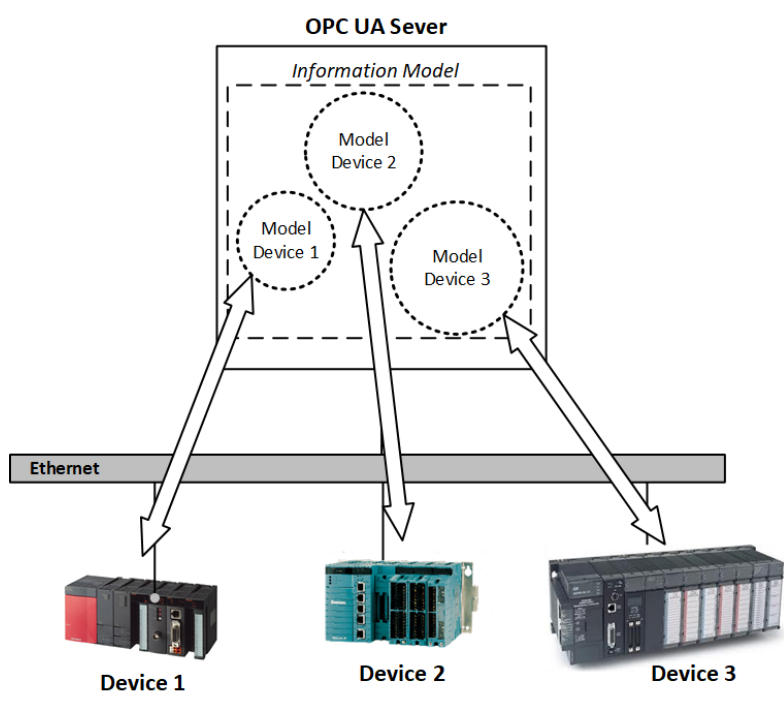
Figure 1. An OPC UA server can manage the information models for each industrial